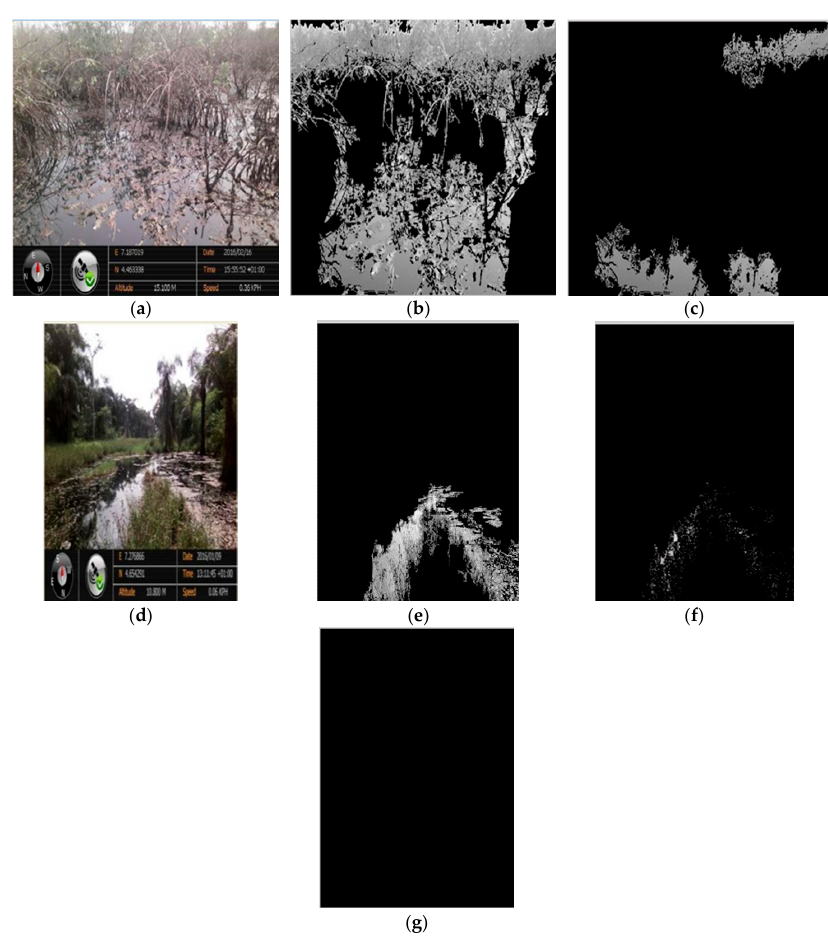
Figure 7. Effect of Weeds on Crude Oil Spill Detection. ( a ) Sample Image OS22; ( b ) primary ROI for OS22 after preprocessing, and sky and color segmentation removal; ( c ) Identified Crude Oil Spill from OS22; ( d ) Sample Image OS25; ( e ) Primary ROI for OS25 after preprocessing, and sky and color segmentation removal; ( f ) Homogeneity Analysis Result for OS25; ( g ) Identified Homogeneity ROI for OS25.